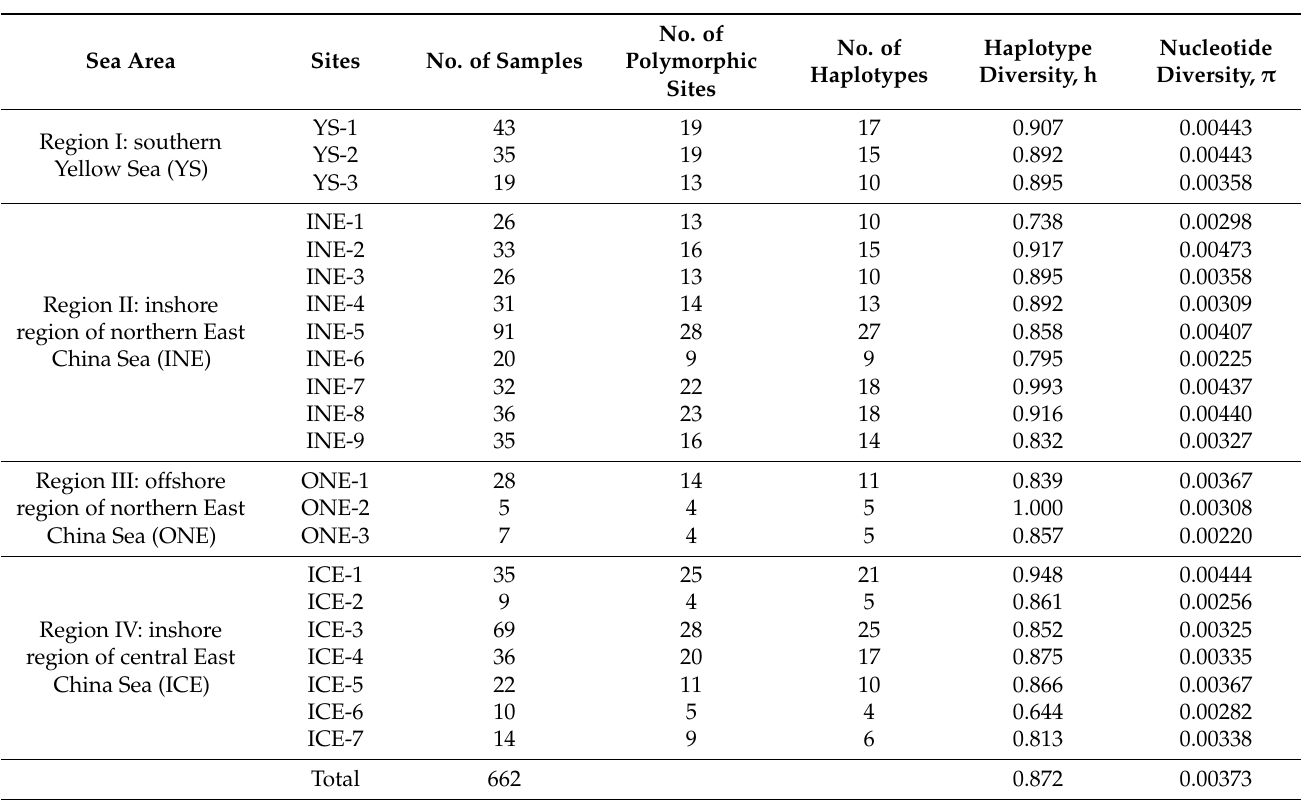
Table 1. Sampling sites and summary statistics of COI sequences in the 22 sites of the large yellow